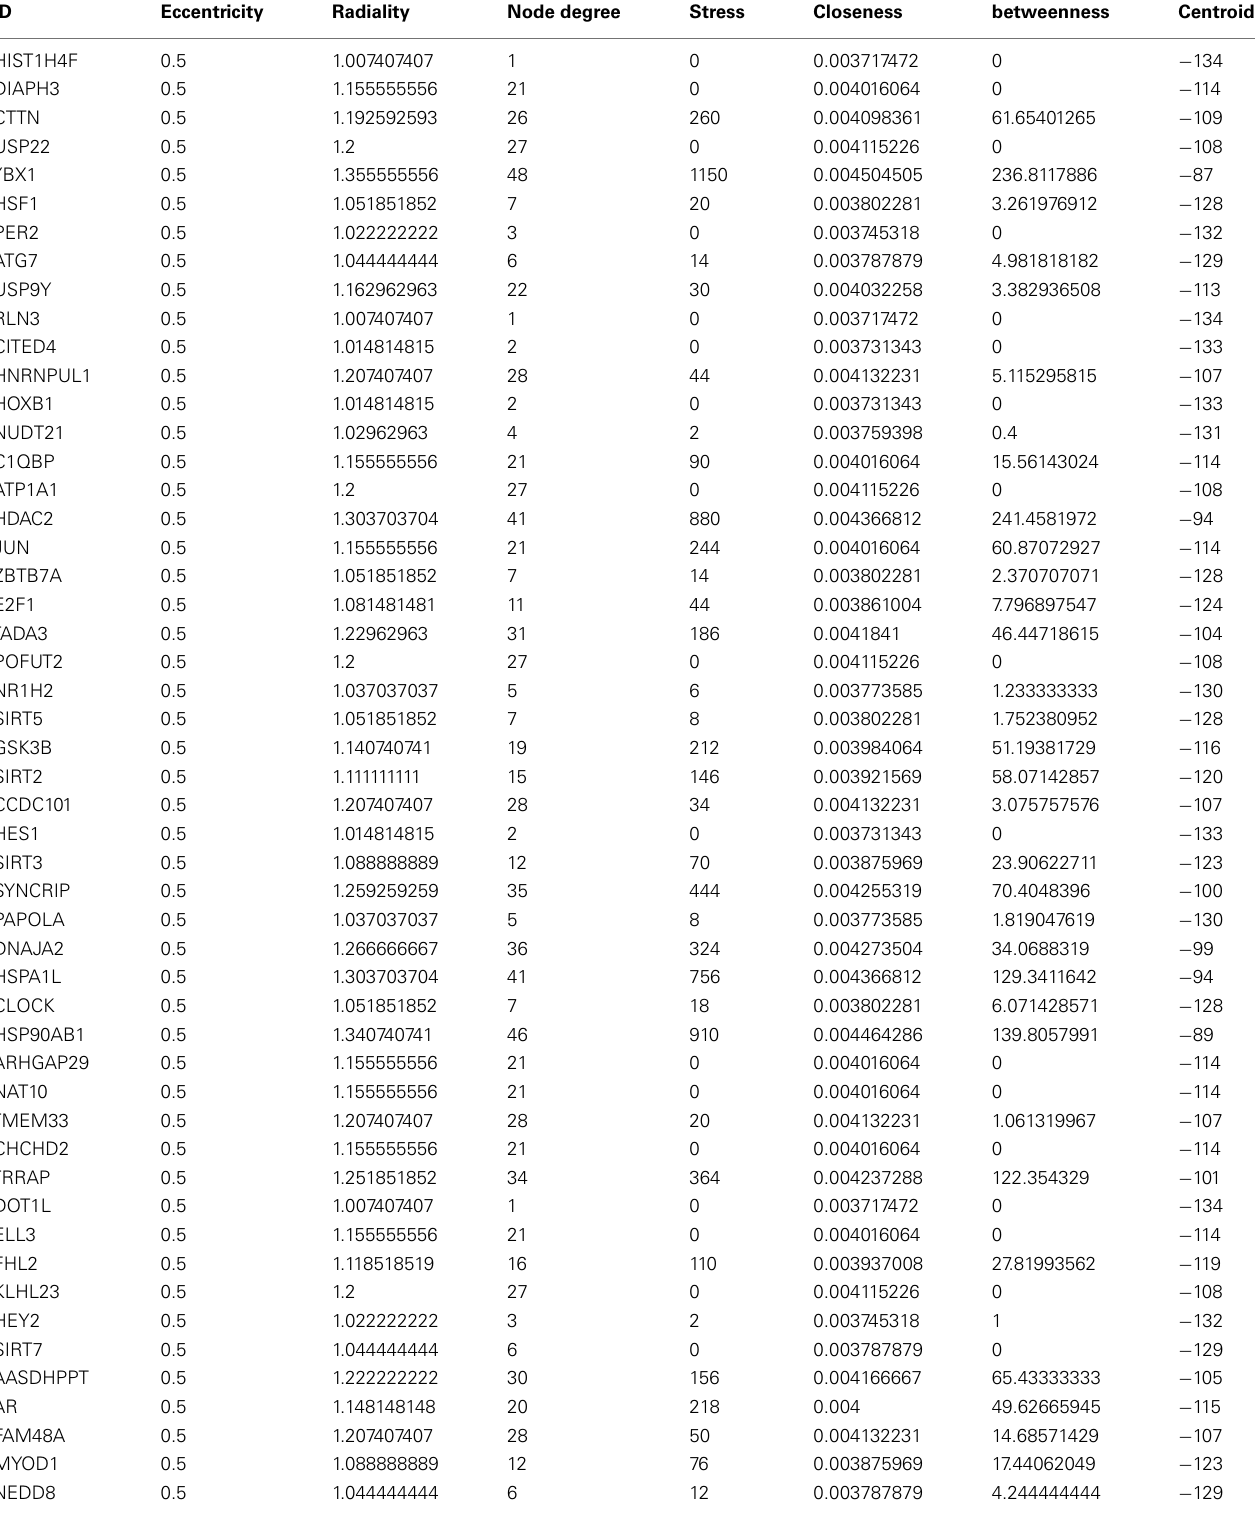
TableA1 |The interacting partners and the centrality values associated with Sirt1 direct interacting